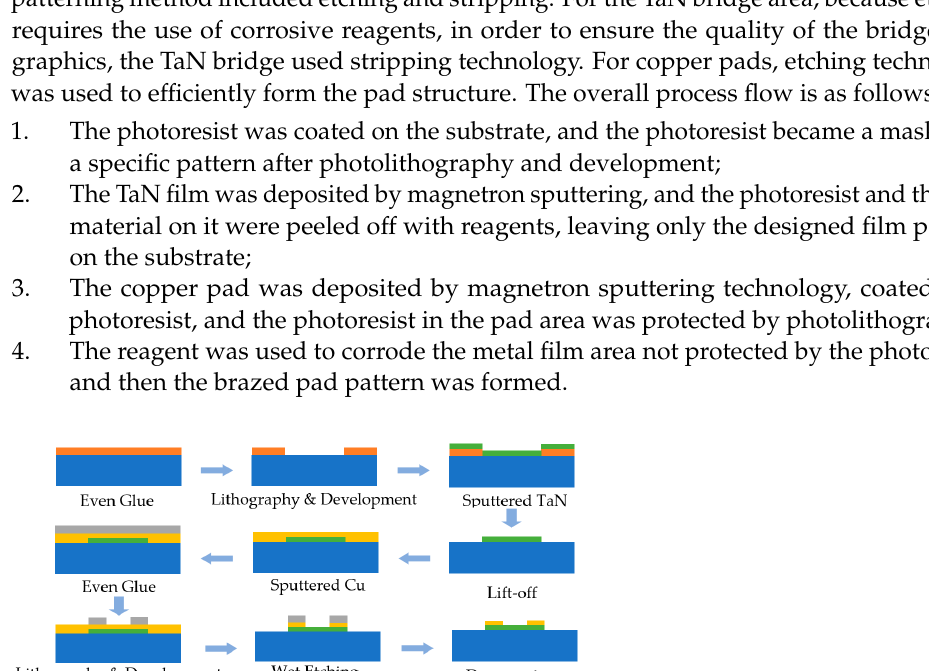
Figure 2. Fabricated Samples of MEMS EC elements. ( a ) Rectangular shape; ( b ) Strip shape; ( c ) An- gular shape. 2.2. Theoretical Analysis of Energy Conversion The mechanism of the function of EC elements is the Joule thermal effect, that is, when the current passes through the conductor, electrical energy is converted into heat energy [25], which was discovered by the British physicist Joule. In the Joule effect, the relationship between electric energy and thermal energy is summarized in the Joule law, and its mathematical expression is as follows: 2 Q I Rt =